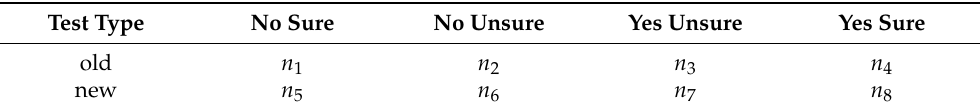
Table 3. The frequencies labels are shown for the various response categories for the experimental task that is associated with model 7B from [23]. Participants responded either yes or no to the test probe and rated their decision either as sure or unsure . The test probes were either old or new corresponding to the probe, respectively, being a memory target or a novel item. For each outcome in the Table there is also a population proportion φ i , i = 1, · · · ,8.